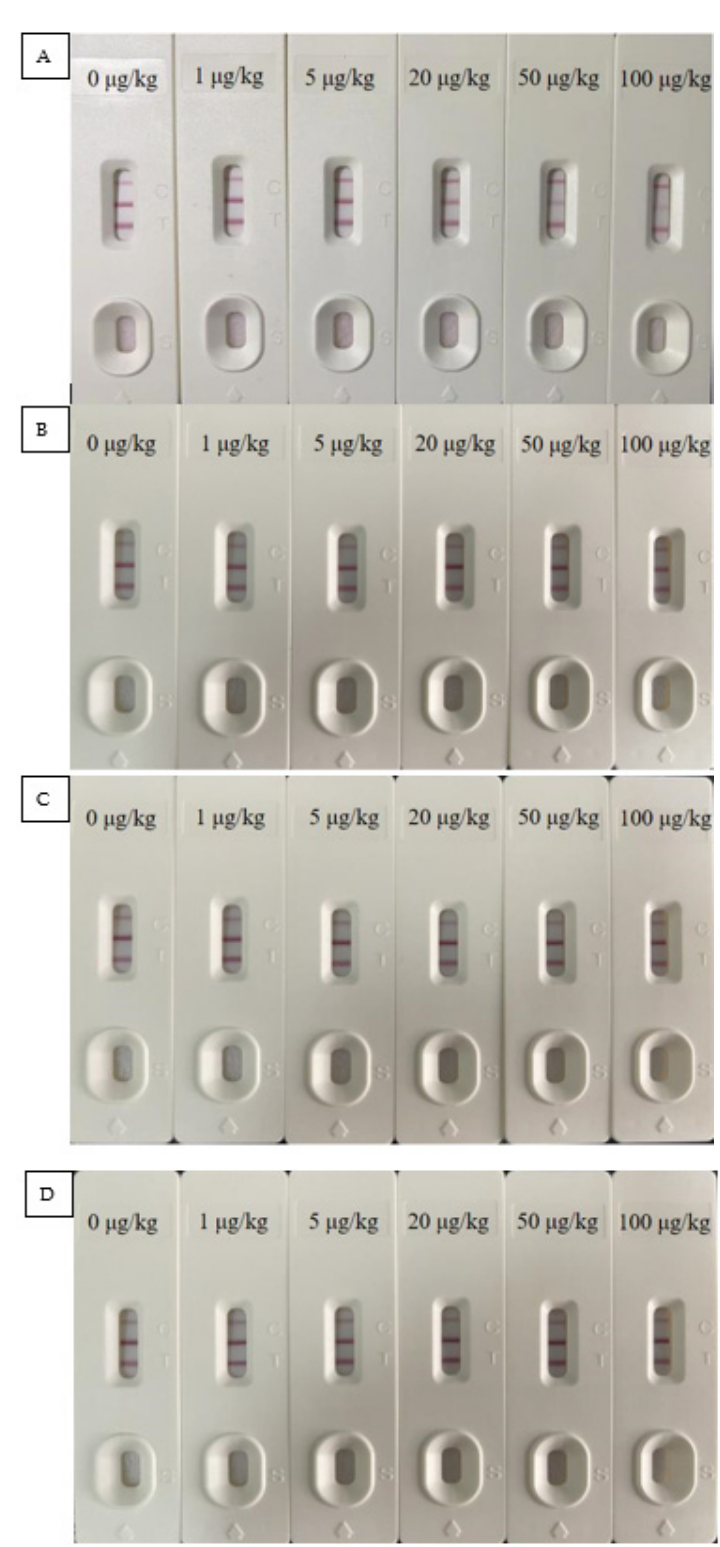
Figure 4. Verification of structural analogs test results, ( A ) AFB 1 , ( B ) AFB 2 , ( C ) AFG 1 , and ( D ) AFG 2 .